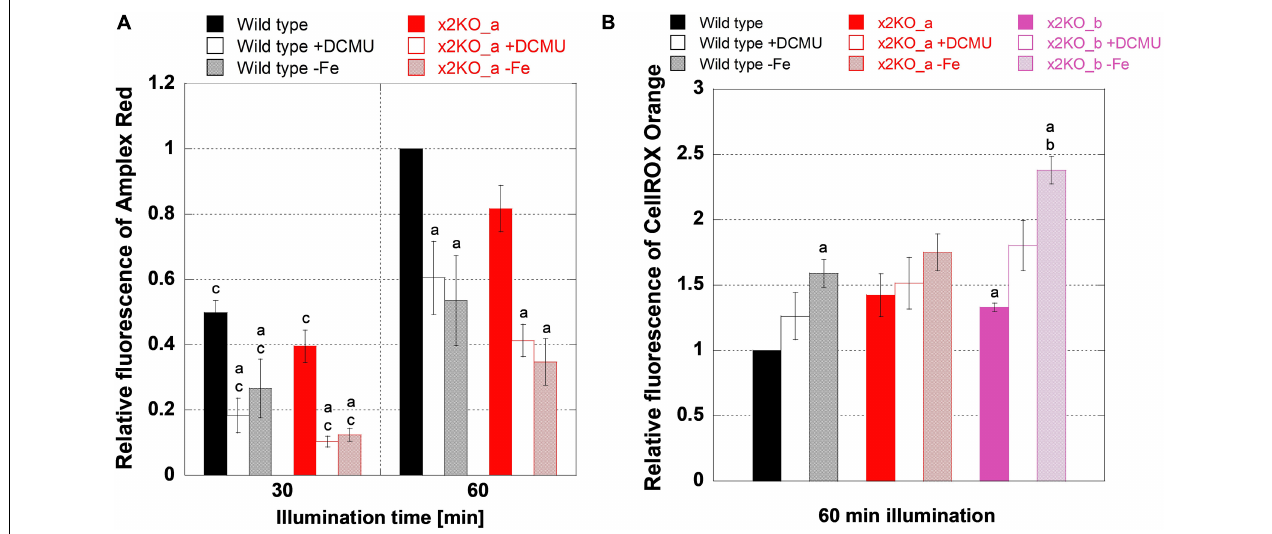
FIGURE 7 | Reactive oxygen species measurements during high light treatment. Low-light-adapted cells were adjusted to 5- µ g ml − 1 Chl a and treated with 10- µ M Amplex Red for H 2 O 2 measurements or 25- µ M CellROX Orange for general oxidative stress measurements prior to 1 h of high light exposure with 500- µ mol photons m − 2 s − 1 . (A) H 2 O 2 measurements in iron-replete wild type and x2KO_a cells, without and with DCMU, and after 10 days of cultivation in the iron-depleted medium. (B) General oxidative stress measurement in iron-replete wild type, x2KO_a, and x2KO_b cells, without and with DCMU, and cells after 10 days of cultivation in the iron-depleted medium. Fluorescence intensities were normalized to wild type after 60 min for each experimental setup. Mean values are derived from 3 to 13 independent replicates. SE is given. Significance was tested by a two-tailed unpaired Student’s T -test: (a) statistically significant in the treated vs. the respective untreated strain; (b) statistically significant in the mutant(s) vs. the wild type exposed to the same treatment; (c) statistically significant in the same strain exposed to the same treatment but comparing two time